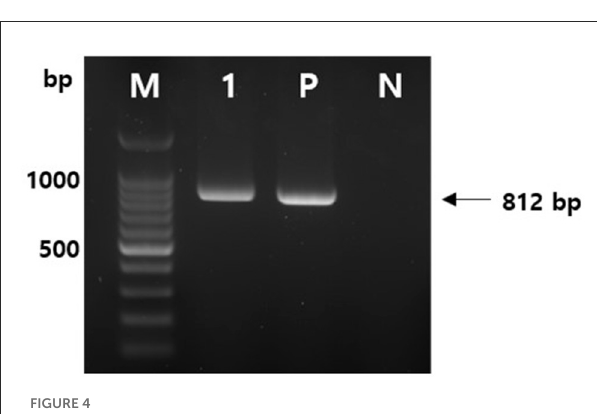
FIGURE4 Amplification of C. tetani tetanospasmin ( tetX ) toxin gene by polymerase chain reaction (PCR). PCR was performed with using the DNA extracted from a single colony of ruminal contents. (M) 100 bp DNA ladder, (1) toxin gene of C. tetani isolate, (P) positive control, and (N) negative